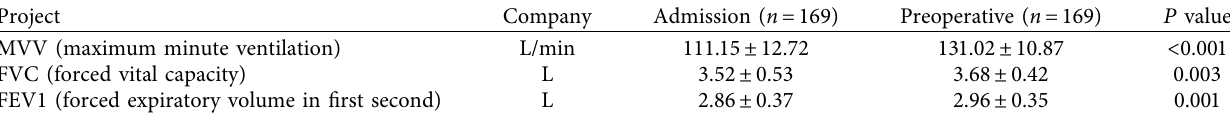
Table 1: Comparison of pulmonary function indexes of patients in accelerated rehabilitation before admission and operation.